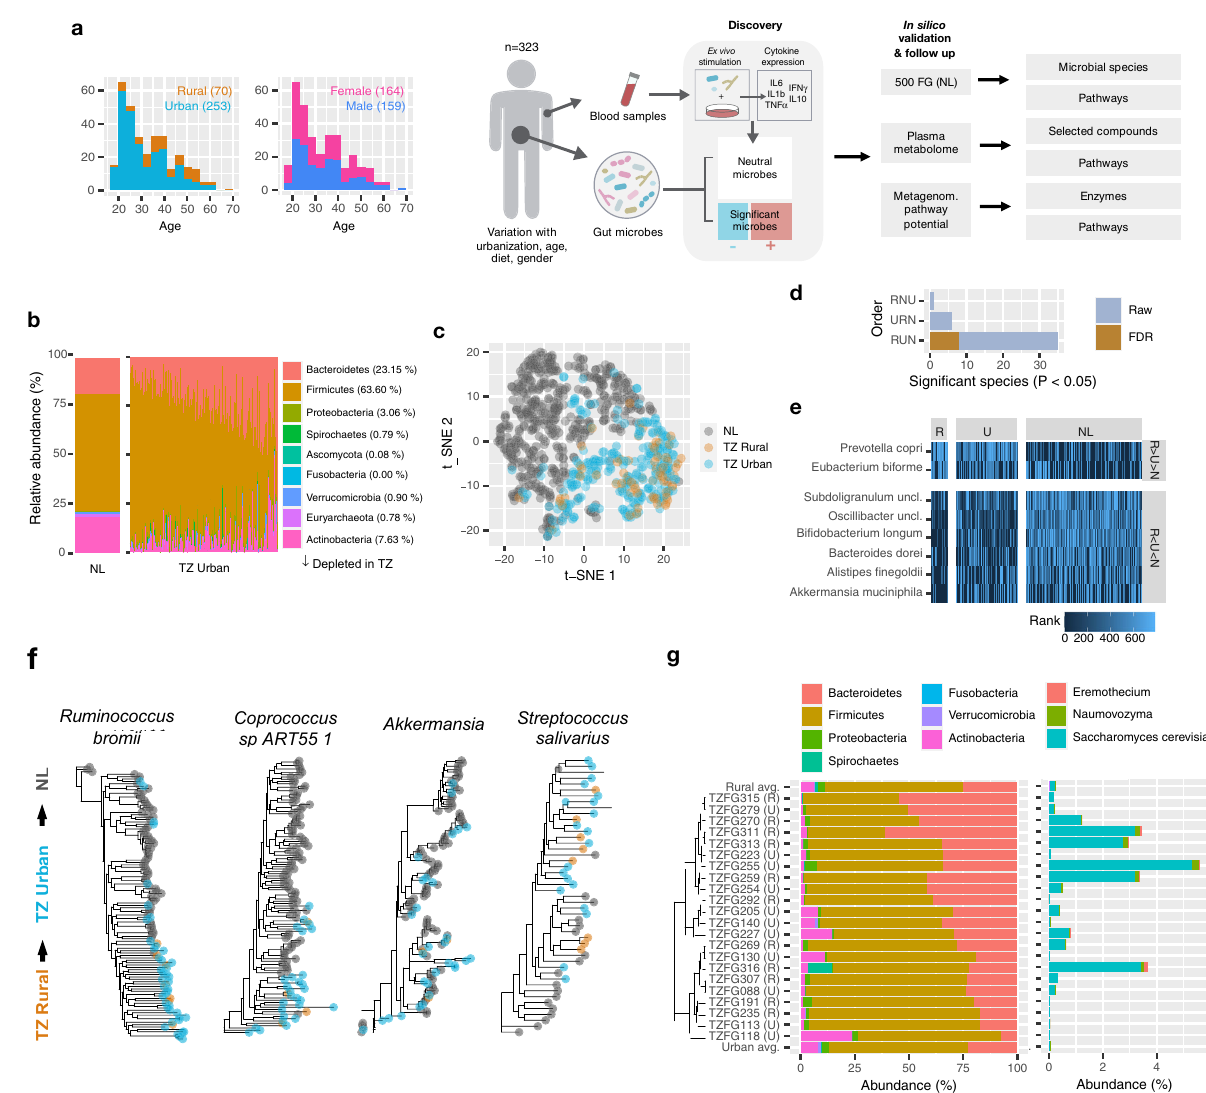
Fig. 1 Microbial and immune system differences change across the Western-Urban-Rural gradient. a Study design overview. Stool metagenomics, plasma metabolomics, and ex vivo blood stimulation were collected for all study participants ( n = 323). The microbes are fi rst tested for signi fi cant effects on inducing differential cytokine expression. The resulting immunomodulatory species are compared against the NL cohort and plasma metabolome of the original TZ samples. Furthermore, immunomodulatory species are compared to non-signi fi cant species for differences in encoded metabolomic pathways using the same stool metagenomics data. b Relative abundance of phyla. Average in the NL (left), Tanzanian urban samples (center), and Tanzanian rural samples (right). c A t-SNE plot based on Jensen-Shannon distance, comparing Tanzanian (TZ) relative species abundance pro fi les with 500 FG cohort from the Netherlands (NL). The two cohorts had 178 microbial species in common (out of 282 Tanzania and 219 Netherlands). d Number of detected species simultaneously changing by all possible gradients: rural-to-urban-to-Netherlands (RUN), urban-to-rural-to-Netherlands (URN), or rural-to- Netherlands-to-Urban (RNU). Bars show the number of signi fi cant species from the double Wilcoxon rank-sum test (see “ Methods ” ), uncorrected or FDR- corrected. e Species simultaneously changing along the TZ rural versus urban and TZ urban versus NL. Displayed are ranked values, samples with no detected species have rank zero. f Selected species diverging in NL, TZ urban, and TZ rural (StrainPhlan). g Twenty-two samples with detected fungi, along with phylum relative abundance. Source data are provided in the Source data fi